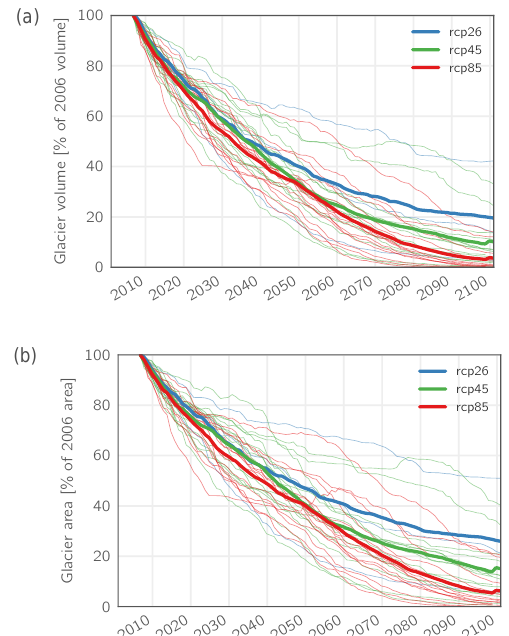
Figure 11. Simulated total glacier volume (a) and area ( b , both shown as changes relative to the year 2006) for all glaciers in the study area and all 31 available climate scenarios. Thin lines indicate individual model results; thick lines show the multi-model mean. The small spikes in the multi-model means for RCP4.5 and RCP8.5 at the very end of the century are due to the fact that three models could only be run until